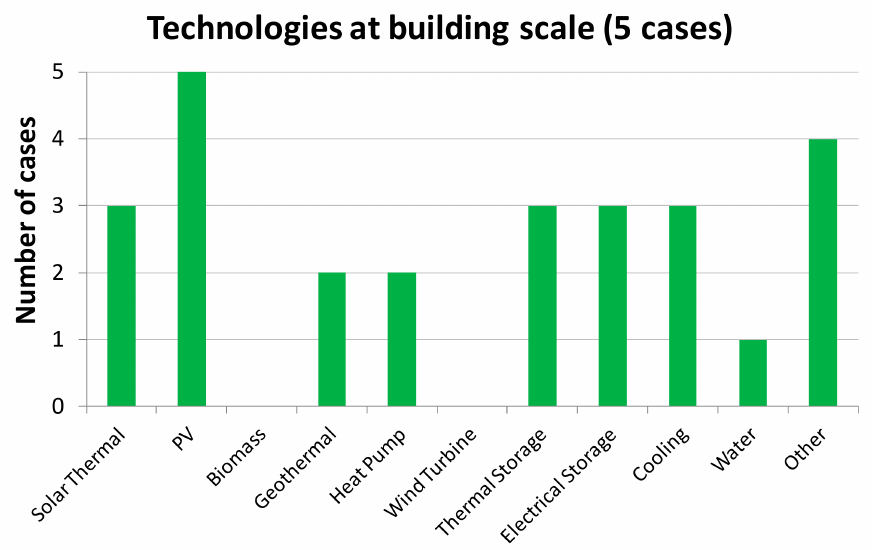
Figure 12. Occurrence of the various technologies installed at the building